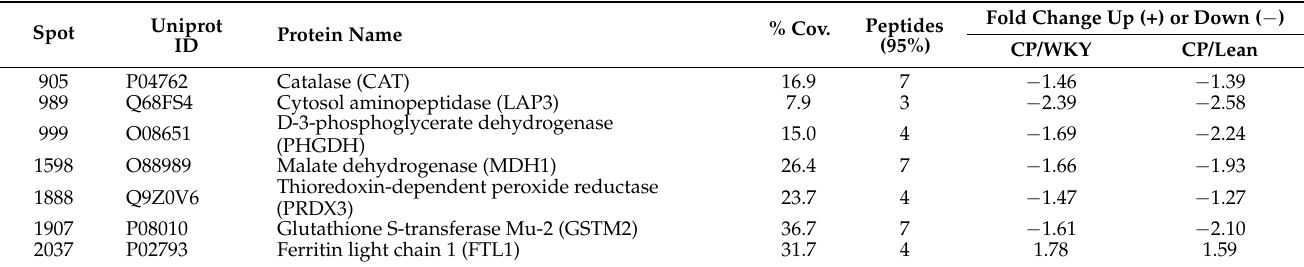
Table 2. List of epididymal adipose tissue proteins that showed significant changes in their expression levels in 25-week-old WKY, Lean, and CP.